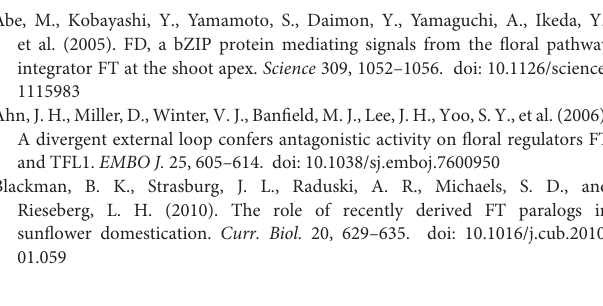
Supplementary Figure 1 | Amino acid sequence alignment of the soybean and Arabidopsis PEBP family members. Supplementary Figure 2 | Expression of GmTFL1 homologs in flowers. Supplementary Figure 3 | mRNA expression of GmFT genes in soybean accessions. Supplementary Figure 4 | GmFT6 mRNA expression in leaves of early (Williams 82) and late (PI229358) flowering soybean accessions across different developmental stages. Supplementary Table 1 | Primers used for full-length cDNA cloning. Supplementary Table 2 | Primers used for RT-PCR and quantitative real-time PCR.